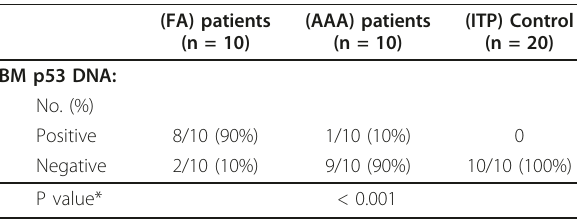
(FA) patients (AAA) patients (ITP) Control (n = 10) (n = 10) (n =